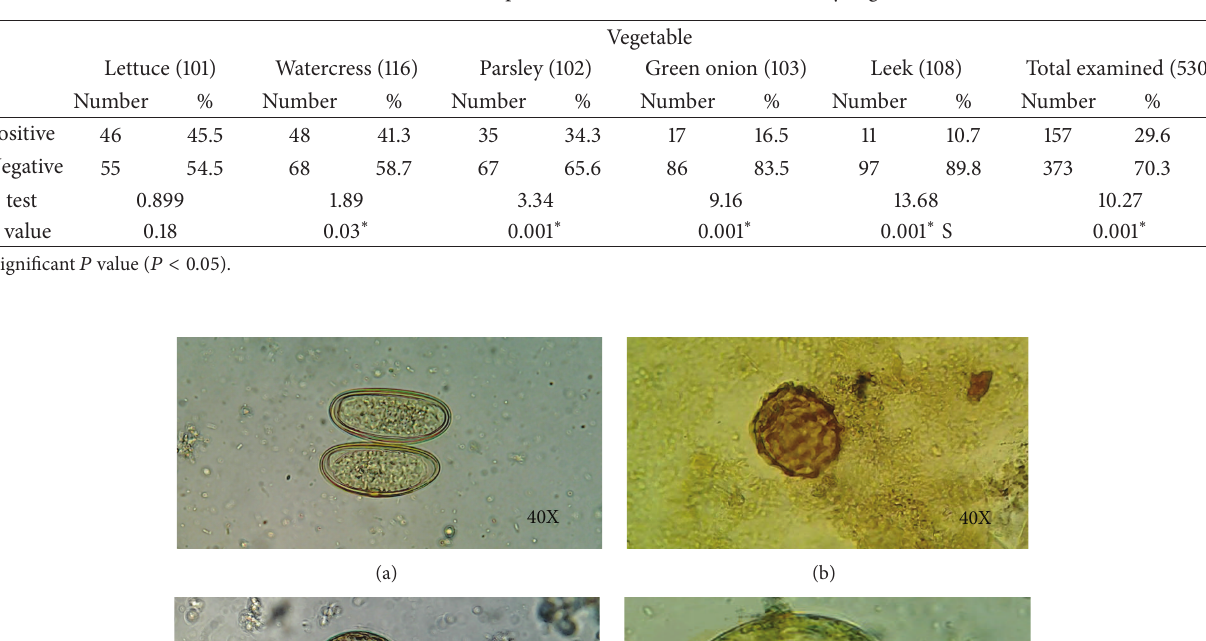
Table 1: Prevalence rate of parasitic contamination on fresh leafy vegetables.